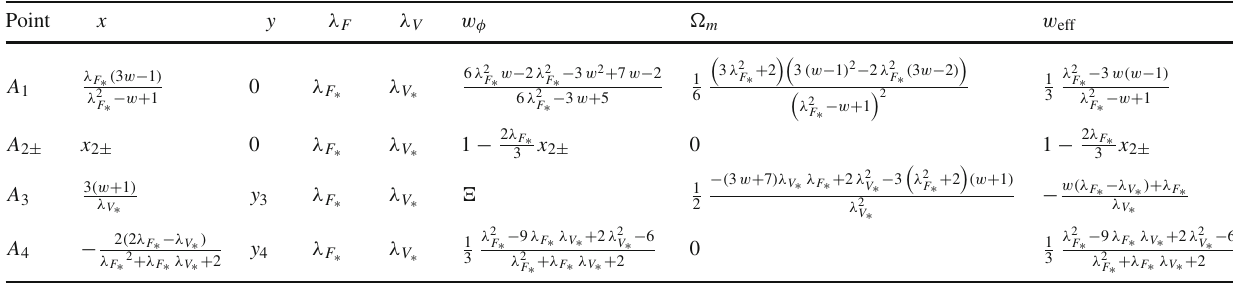
Table 1 Critical points of the system